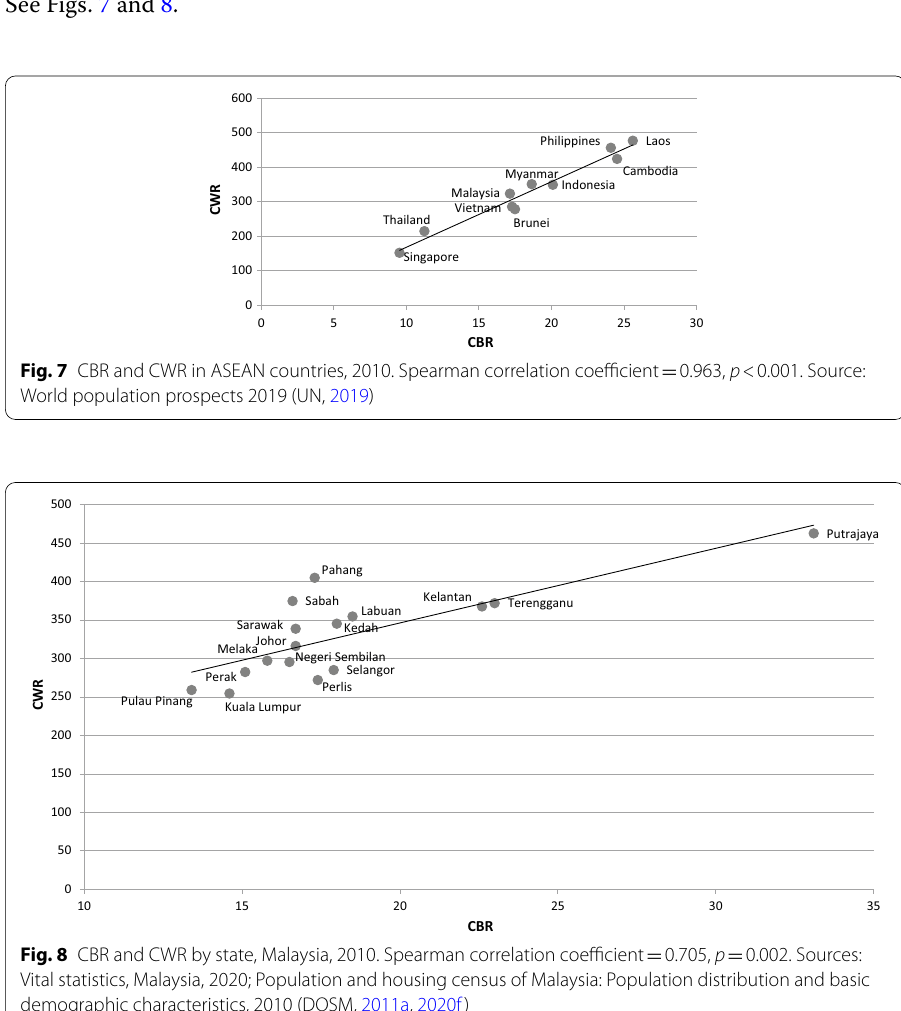
0.705, p 0.002. Sources: = =